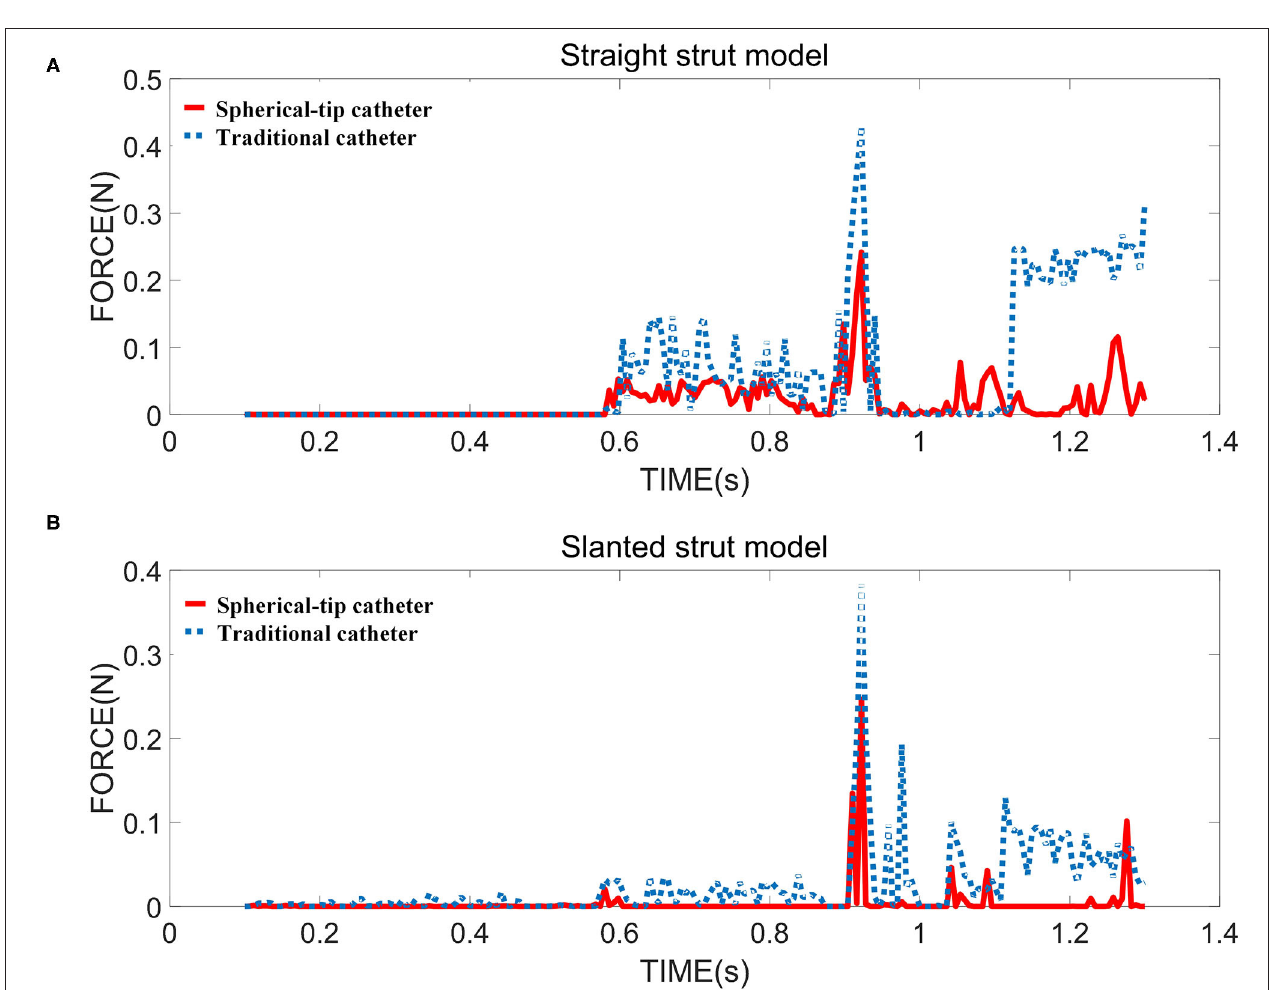
FIGURE 9 | The contact force between strut and sensor for two strut models in the FE simulation i.e., (A) straight strut model and (B) slanted strut model.